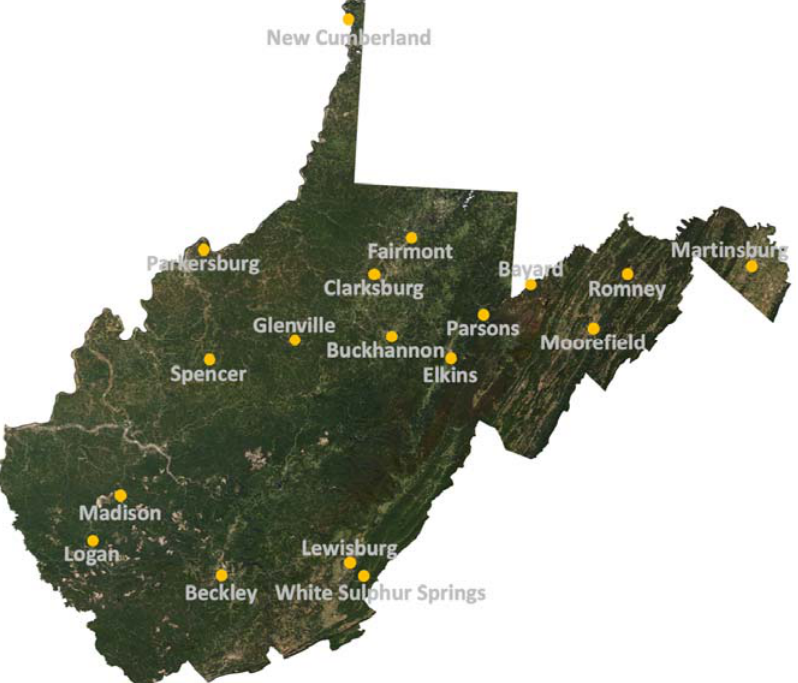
Figure 1. Observed climate record site locations in West Virginia, USA. Satellite image credit: National Aeronautics and Space Administration (NASA; [48]).